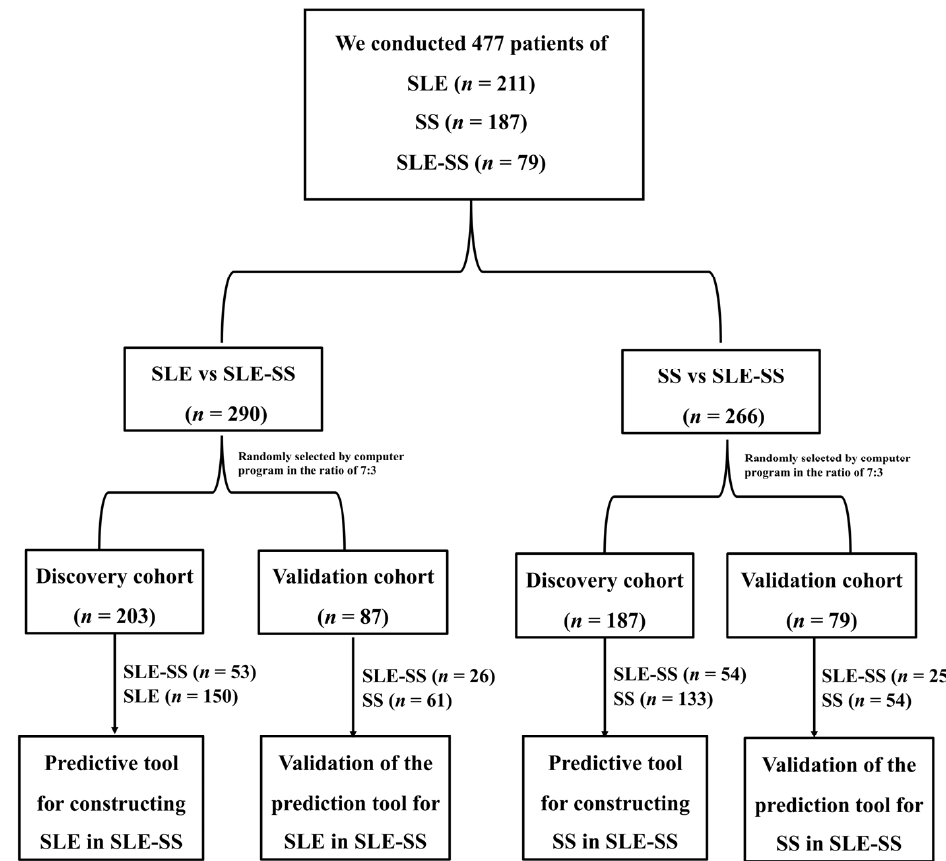
Figure 1. Flowchart for constructing the SLE or SS in the SLE-SS prediction tool.